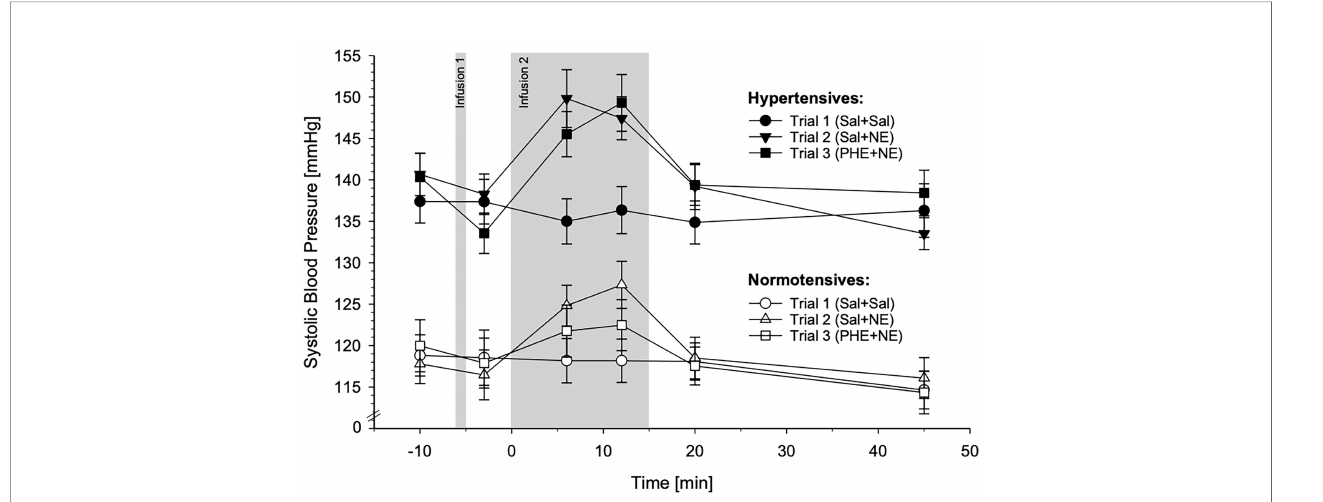
FIGURE 3 | Systolic blood pressure (SBP) reactivity to the three different substance infusion-trials (trial 1: Sal+Sal, circles; trial 2: Sal+NE, triangles; trial 3: PHE+NE, rectangles) in hypertensive participants (HT; black symbols; n = 23) and normotensive controls (NT; white symbols; n = 24) ( mean ± SEM ). SBP reactivity differed across the three trials between HT and NT as revealed by the calculated general linear model (interaction trials-by-group-by-time: p = .002). Pairwise trial comparisons by means of general linear models : In comparison to NT, HT displayed higher SBP reactivity to Sal+NE as compared to Sal+Sal ( p = .033). Moreover, HT and NT differed in their SBP reactivity to PHE+NE as compared to Sal+Sal ( p = .015) and to Sal+NE ( p = .007): In NT, SBP reactivity to PHE+NE was markedly reduced as compared to Sal+NE, whereas HT showed a similar reactivity to Sal+NE and PHE+NE. Within each trial by means of repeated measures ANCOVAs : HT showed higher SBP reactivity to Sal+NE and PHE+NE ( p ’ s ≤ .038) but not to Sal+Sal ( p =